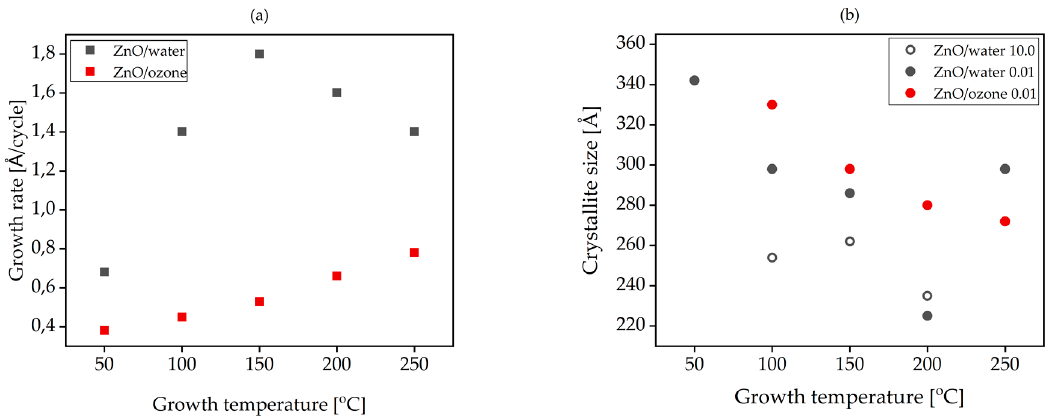
Figure 1. ( a ) Growth rate of ZnO layers vs. growth temperature for water-based and ozone-based processes. ( b ) Crystallite size in the obtained layers depending on crystallographic orientation: (10.0) and (00.1).